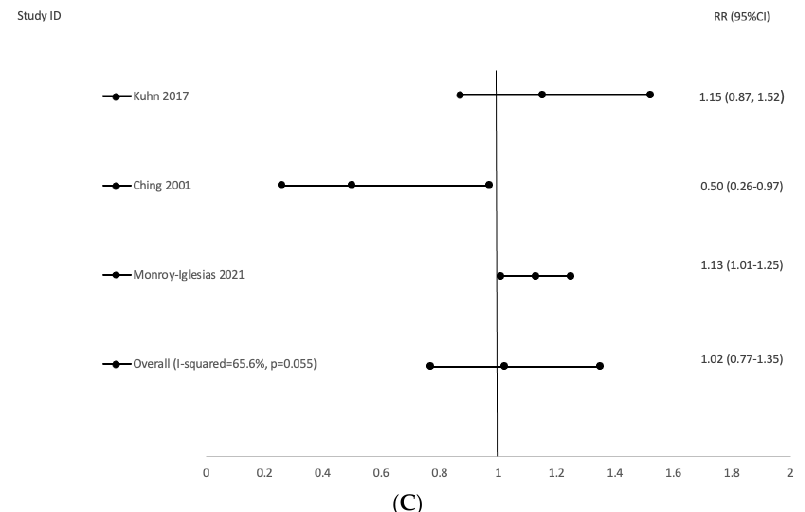
Figure 4. Heme Forest plot for the association between elevated serum total bilirubin (STB) and cancer risk for ( A ) Colorectal cancer, ( B ) Lung cancer, and ( C ) Breast